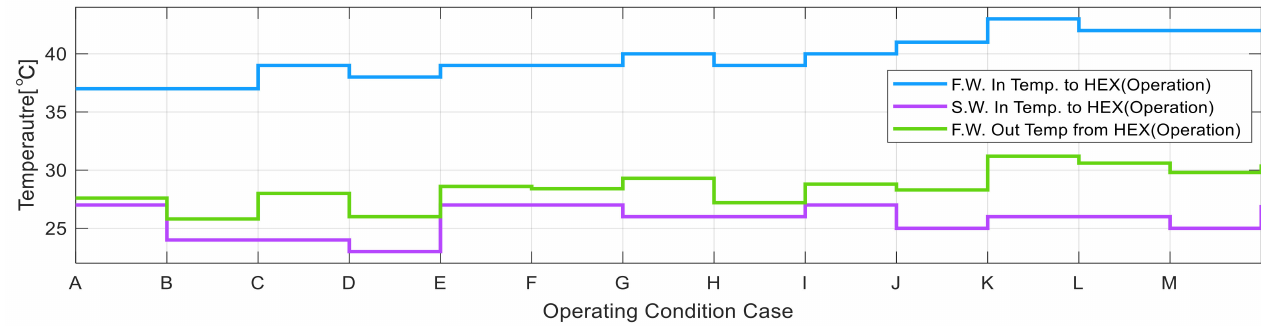
Figure 10. Operational data graph for FW inlet/outlet and SW outlet temperature from/to HEX.